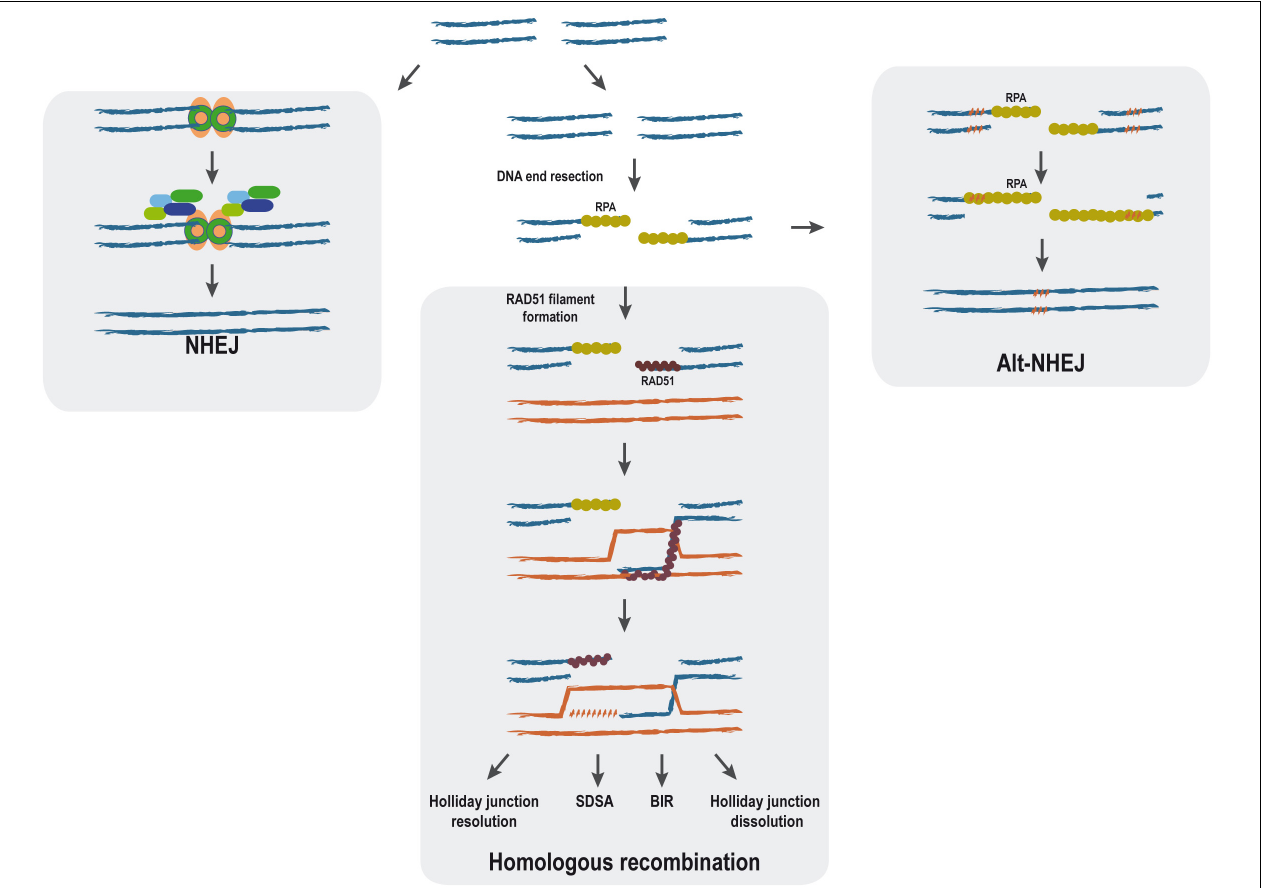
FIGURE 1 | Main double-strand break (DSB) repair pathways. The main steps of non-homologous end joining (NHEJ), alternative non-homologous end-joining, and homologous recombination repair mechanisms are represented. DNA double-strand breaks can be repaired without end processing by NHEJ (left). In response to specific cues, the ends can be processed by a nucleolytic degradation of one strand to form long tails of ssDNA in the process known as resection. When this happens, classical NHEJ is effectively blocked. Sometimes, ssDNA formation will expose short stretches of microhomology (right, punctuated orange pattern), and the break will be repaired by Alt-NHEJ (right). Alternatively, homologous recombination can proceed using the resected DNA. Although HR can proceed through different HR pathways [holiday junction resolution, synthesis-dependent strand annealing (SDSA), break-induced replication (BIR), and holiday junction dissolution], all of them share the initial